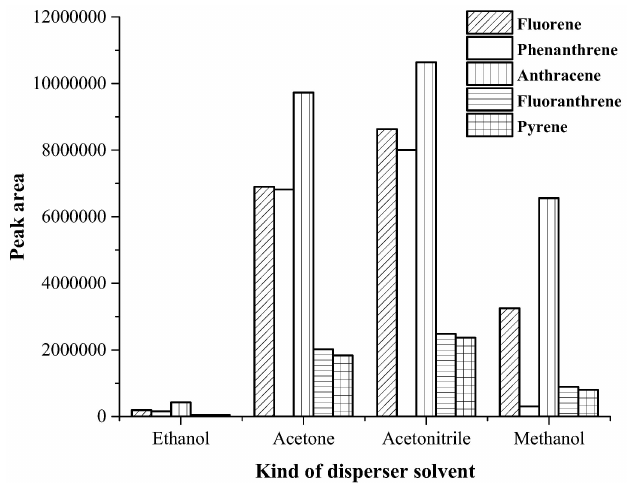
Figure 3. Effect of kind of disperser solvent on the extraction efficacy.